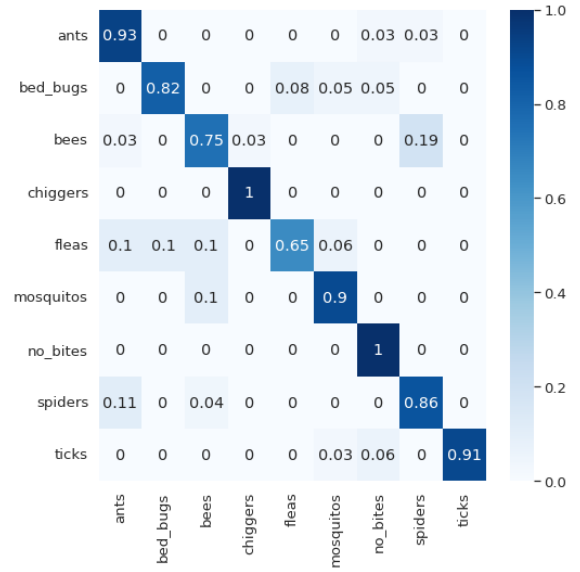
Figure 15. Normalized confusion matrix for Neural Network Stacking